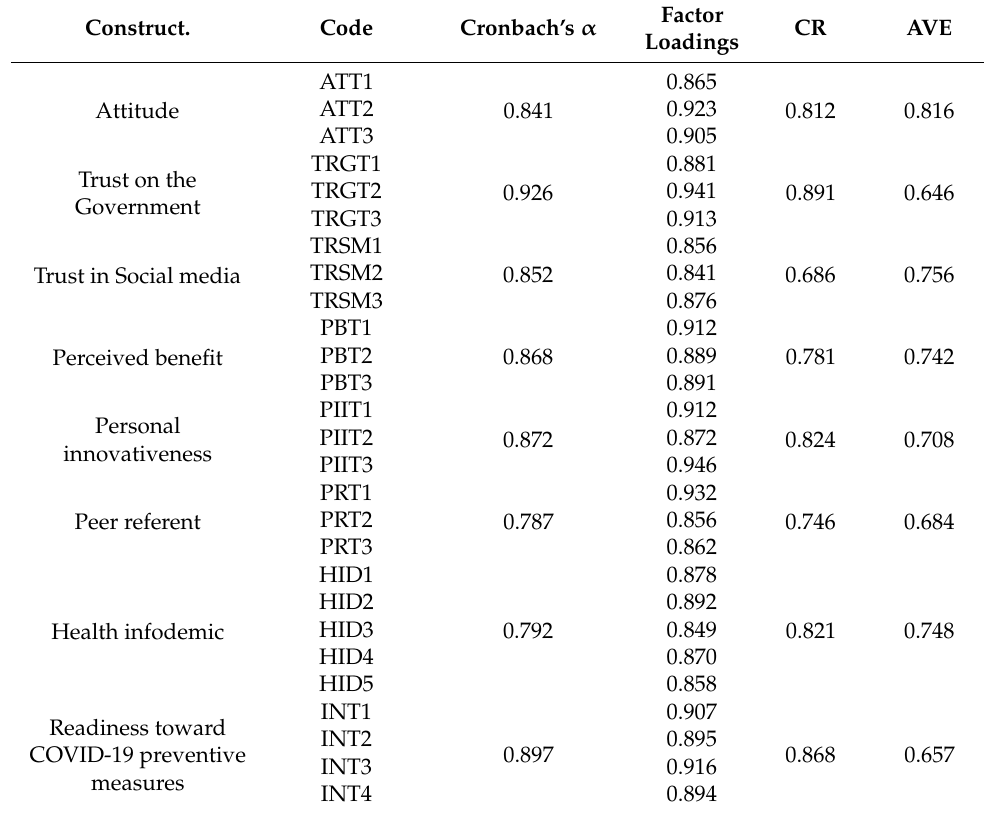
Table 2. Results of reliability and validity